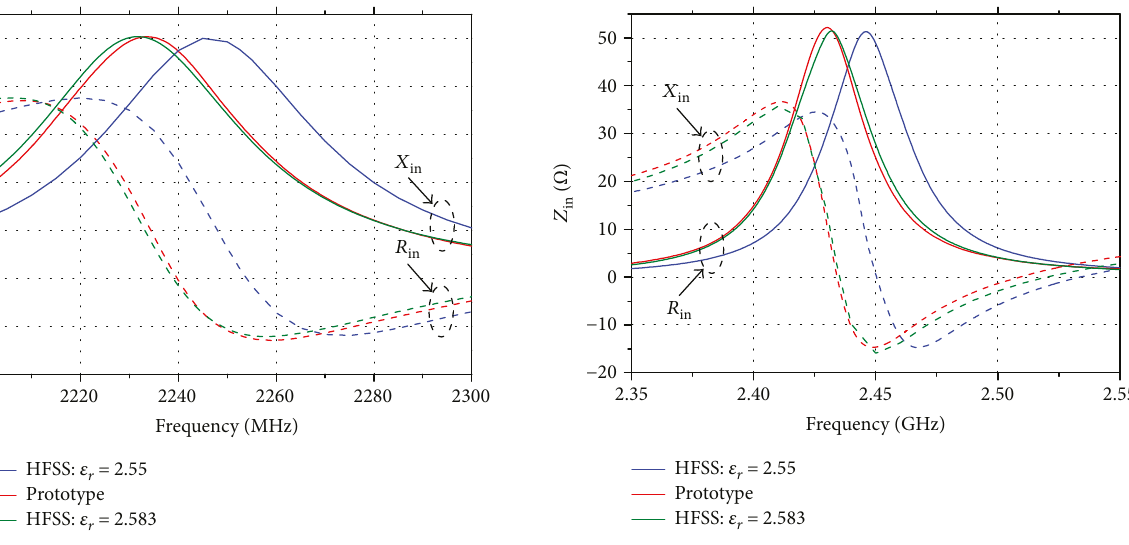
Figure 25: Input impedance of the SIW antenna.